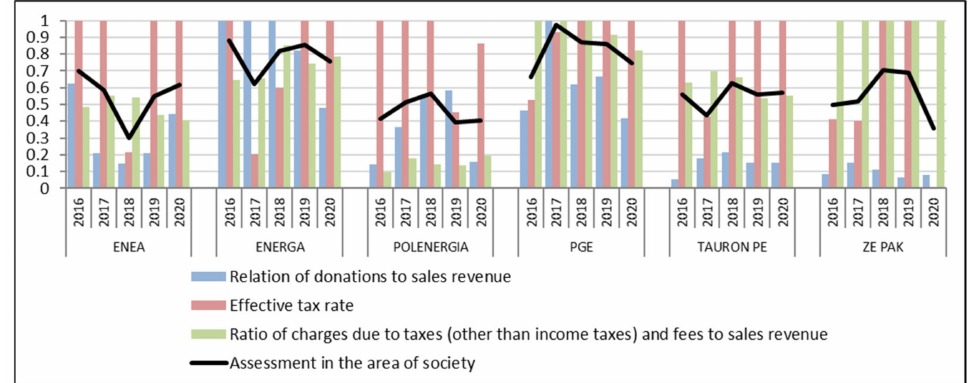
Figure 7. Assessment of the investigated companies’ activities in the area of society.